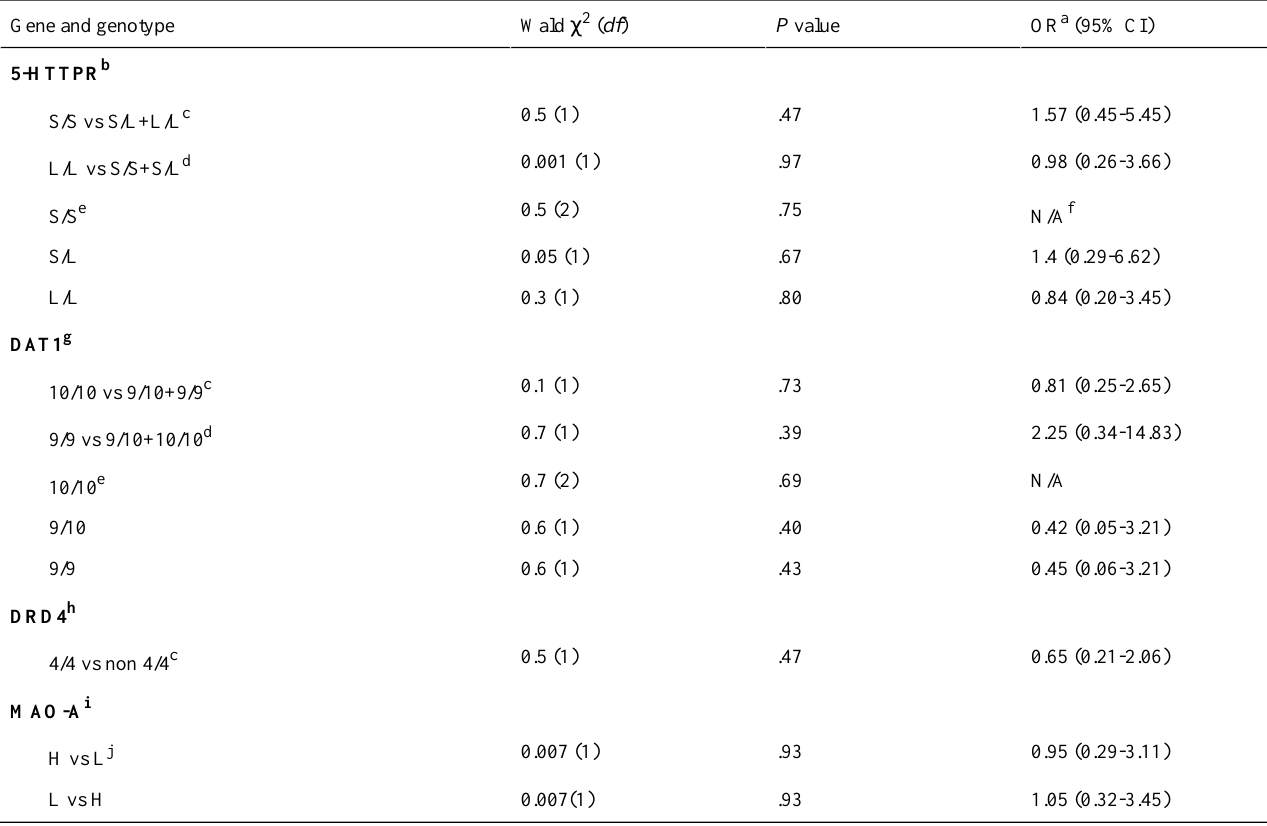
Table 3. Association between internet addiction and genetic polymorphisms in serotonin-transporter, dopamine active transporter 1, dopamine D4 receptor, and monoamine oxidase A among male